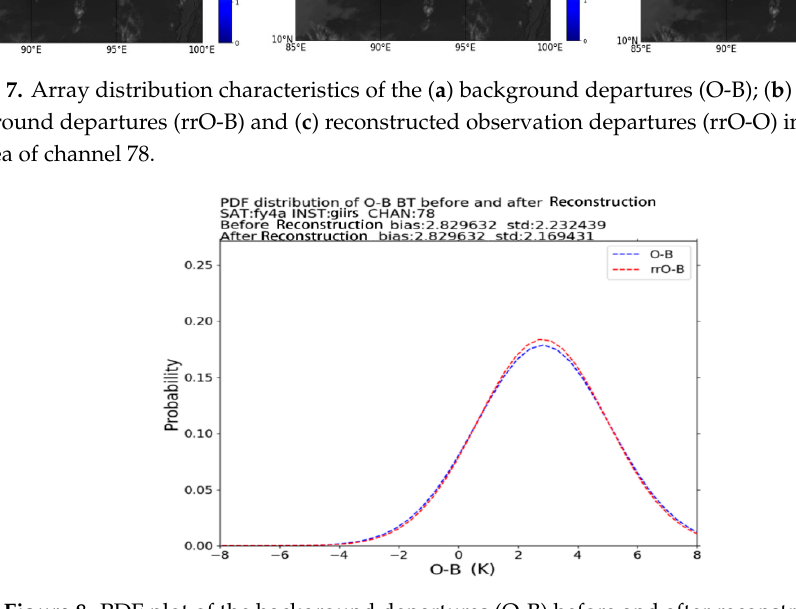
Figure 8. PDF plot of the background departures (O-B) before and after reconstruction.